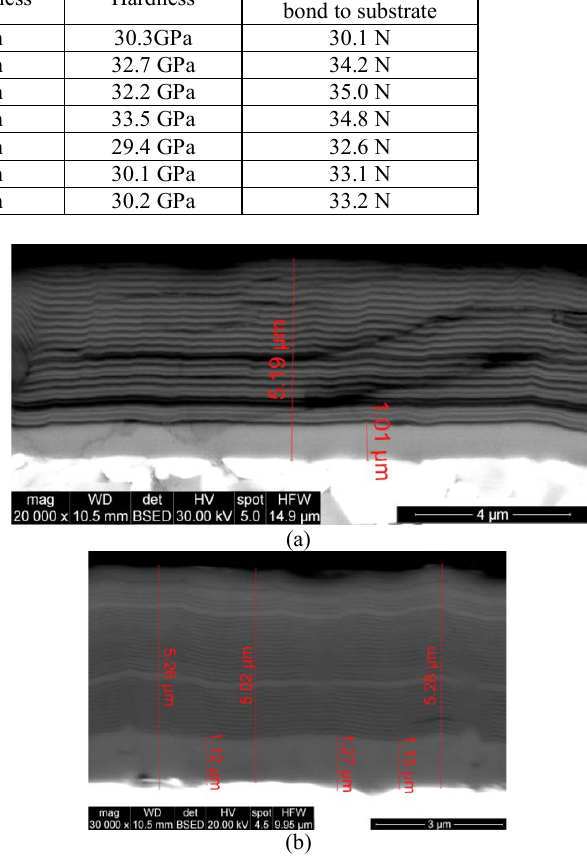
Fig. 2. Structure on cross-section of coatings Zr-ZrN- (ZrCrNbAl)N (a) and Ti-TiN-(TiCrAl)N (b) with thickness of about 5